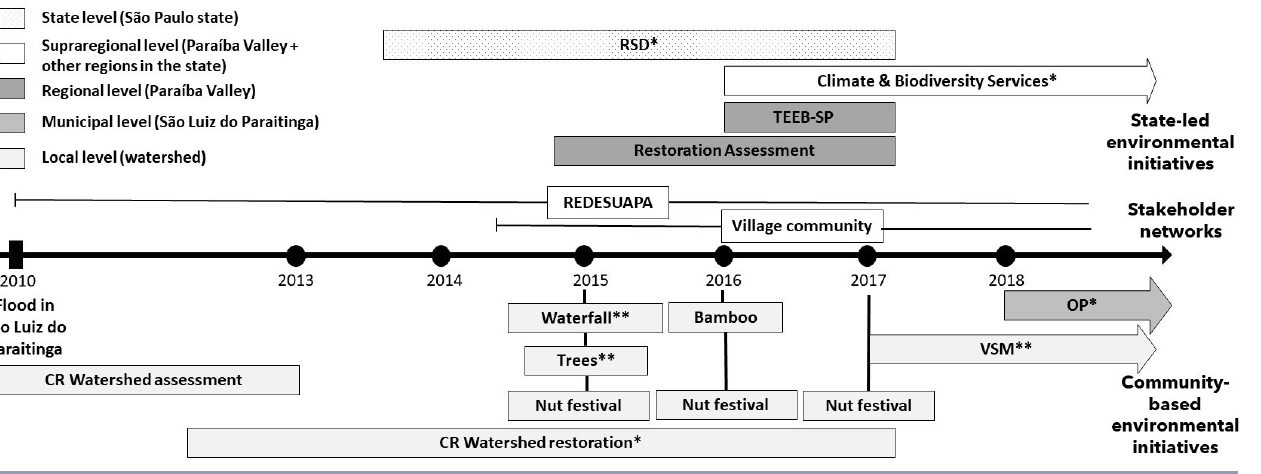
Fig. 2 . Environmental initiatives affecting the Chapéu River (CR) watershed in São Luiz do Paraitinga municipality, southeast Brazil: RSD Project = Rural Sustainable Development Project; Climate & Biodiversity Services = Recovery and protection of climate and biodiversity services in the Paraíba do Sul basin of the Atlantic Forest of Brazil; TEEB-SP = The Ecology and Economics of Biodiversity – São Paulo State; Restoration Assessment = Restoration Opportunities Assessment (ROAM Methodology) in the Paraíba Valley, São Paulo State; REDESUAPA = The Upper Paraíba River Sustainable Development Network; Village community = the village community of Catuçaba; OP = Our Paraitinga project; VSM = Village Street Market; Waterfall = waterfall collective cleanup (“The Waterfall is Ours” movement); Trees = tree planting by the Chapéu River; Bamboo = bamboo planting along the Chapéu riverbank; Nut festival = The Araucaria pine-nut festival; CR Watershed assessment = Environmental Assessment of the Chapéu River watershed; CR Watershed restoration = Environmental Restoration of the